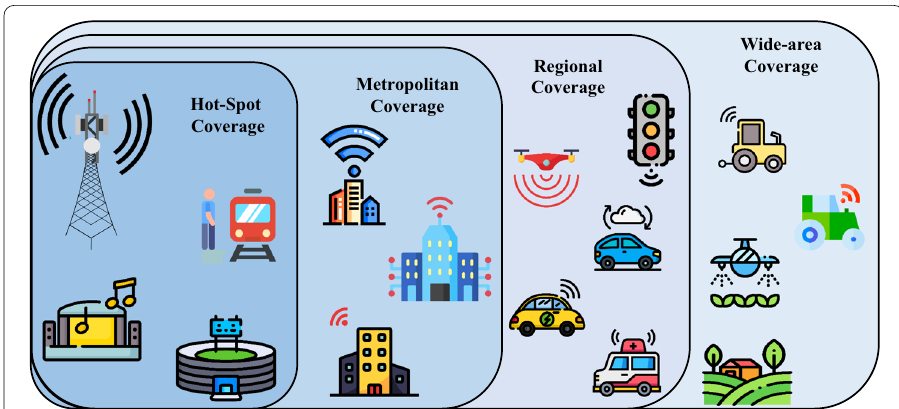
Fig. 1 Potential mmWave coverage scenarios of 5G mobile networks and